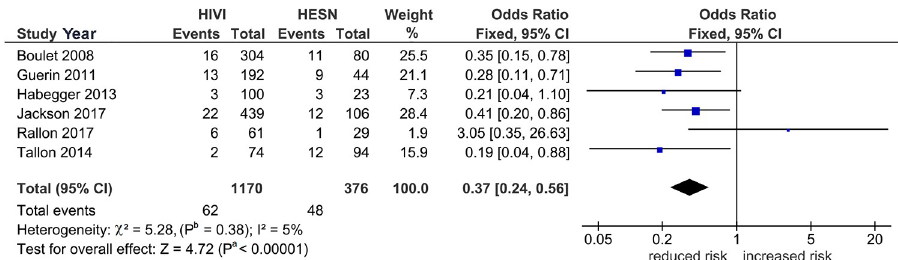
Fig 4. Post-outlier (PSO) summary effects of 3DS1S1 on HIV acquisition in Caucasians. Diamond denotes the pooled odds ratio (OR) indicating reduced risk (OR 0.37). Squares show the OR of each study. Horizontal lines on either side of each square represent 95% confidence intervals (CIs). Significance from the Z test for overall effect is high (P a < 0.00001). The χ 2 test shows reduced heterogeneity (P b = 0.38, I 2 = 5%); I 2 : a measure of variability expressed in %.